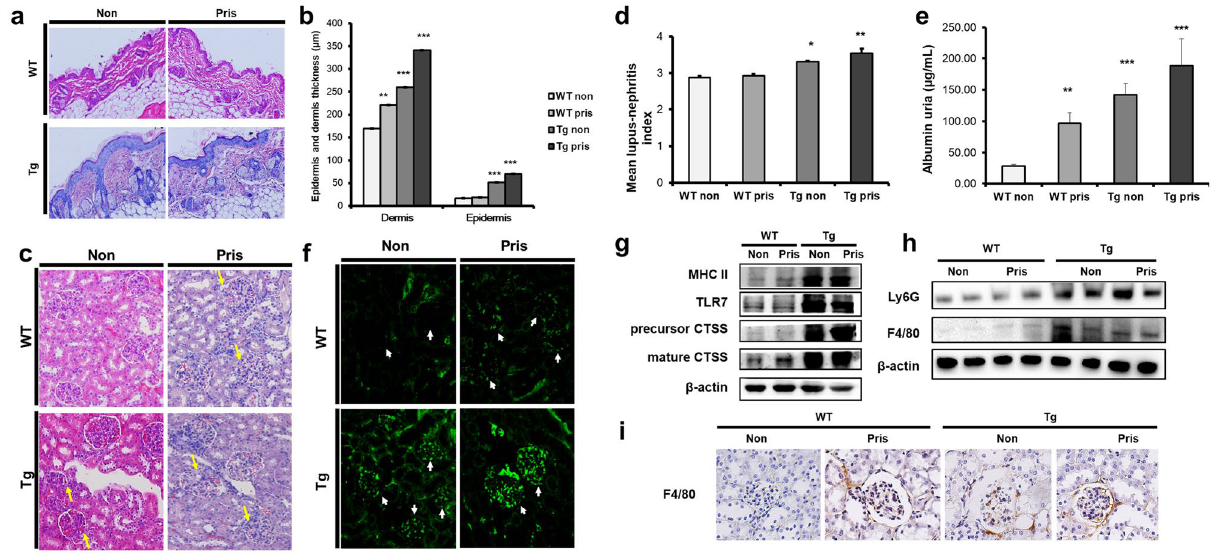
Figure 4. Histology of skin and renal pathology in pristane-injected cathepsin S (CTSS)—overexpressing mice. ( a ) H&E-stained section of dorsal skin (× 200 magnification) from WT and TG mice 8 months after treatment with pristane. ( b ) Epidermal and dermal thickness of dorsal skin from WT and TG mice. WT wild type, TG transgenic. ** p < 0.01; *** p < 0.001, versus WT non-treated group. ( c ) H&E-stained kidney sections (× 200 magnification) from WT and TG mice 8 months after treatment with pristane. Arrows indicate glomerular abnormalities. ( d ) Renal histological scores represent nephritis severity in WT and TG mice 8 months after pristane injection. ( e ) Albumin concentration in urea measured by ELISA. ( f ) Glomerular immunoglobulin (IgG) and complement (C3) deposition analysed by direct immunofluorescence in WT and TG mice 8 months after treatment with pristane. Representative western blot showing, ( g ) MHC II, TLR7 and CTSS expression in the spleen and ( h ) expression of F4/80 + monocytes/macrophages and Ly6G + neutrophils in the kidneys. β-actin was used as a loading control. Precursor and mature CTSS bands were cropped from different gel and grouped together. Other band were cropped from the different gel and grouped together. Original blots are shown in Supplementary Information ( i ) F4/80 + monocyte/macrophage infiltration analysed by immunohistochemistry (× 200 magnification) in WT and TG mice 8 months after treatment with pristane. WT wild type, TG transgenic. * p < 0.05; ** p < 0.01; *** p < 0.001, versus untreated WT